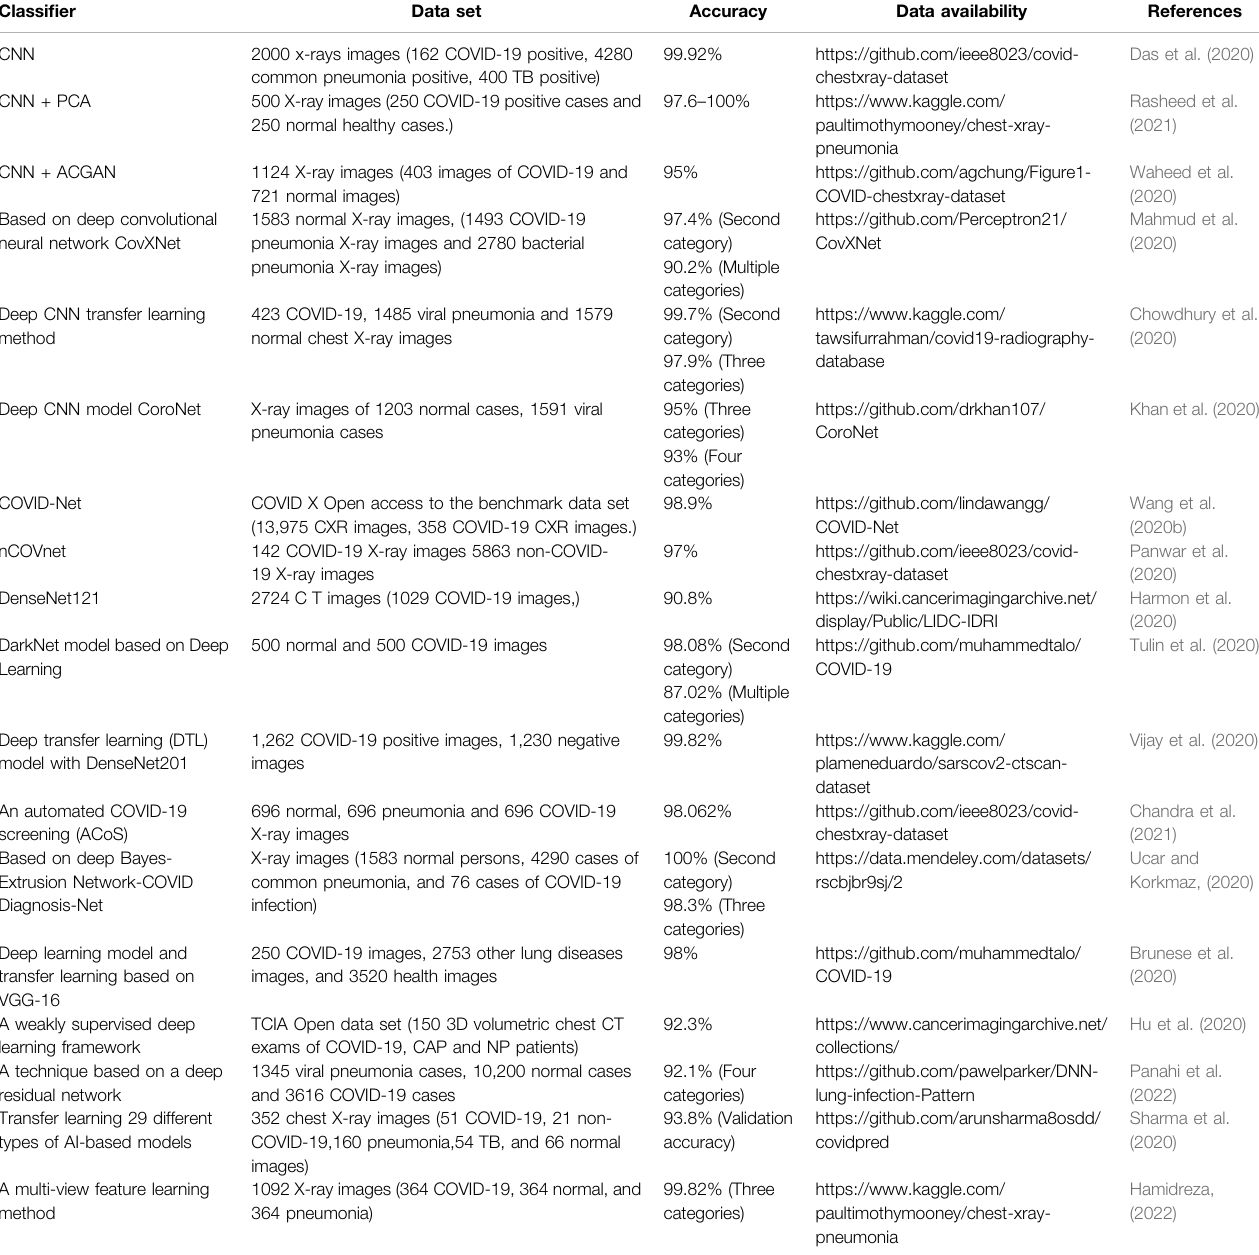
TABLE 1 | Main methods of Medical Imaging for